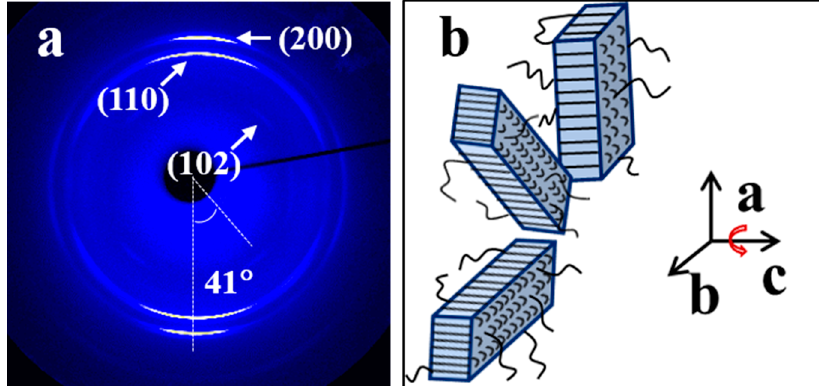
Figure 4. ( a ) A WAXD pattern with main reflections being indexed of an H-PCL / PVC blend film cooled from 100 ◦ C down to 40 ◦ C, immediately stretched to a draw ratio of λ = 3 at a strain rate of 6 mm / min and then crystallized at 40 ◦ C under strain for 12 h. ( b ) A sketch illustrating the ring-fiber orientation of H-PCL crystals in the blend. The stretching direction is vertical.